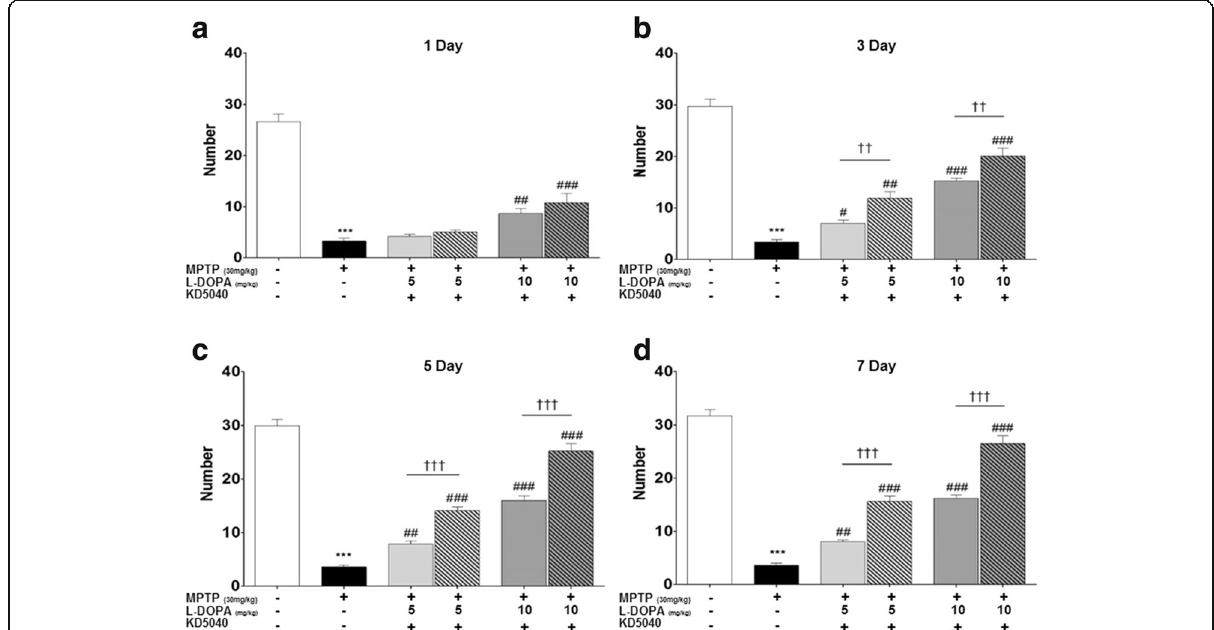
Fig. 3 Effects of combination treatment on days 1 ( a ), 3 ( b ), 5 ( c ), and 7 ( d ) after first treatment with KD5040 based on the rearing test. The -dopa groups (LL and ML) significantly increased relative to the MPTP group, which increased further after number of rearing behaviors in both L -dopa (5 mg/kg), ML: medium dose of -dopa (10 mg/kg). co-administration with KD5040. C: control, M: MPTP, K: KD5040, LL: low dose of L L